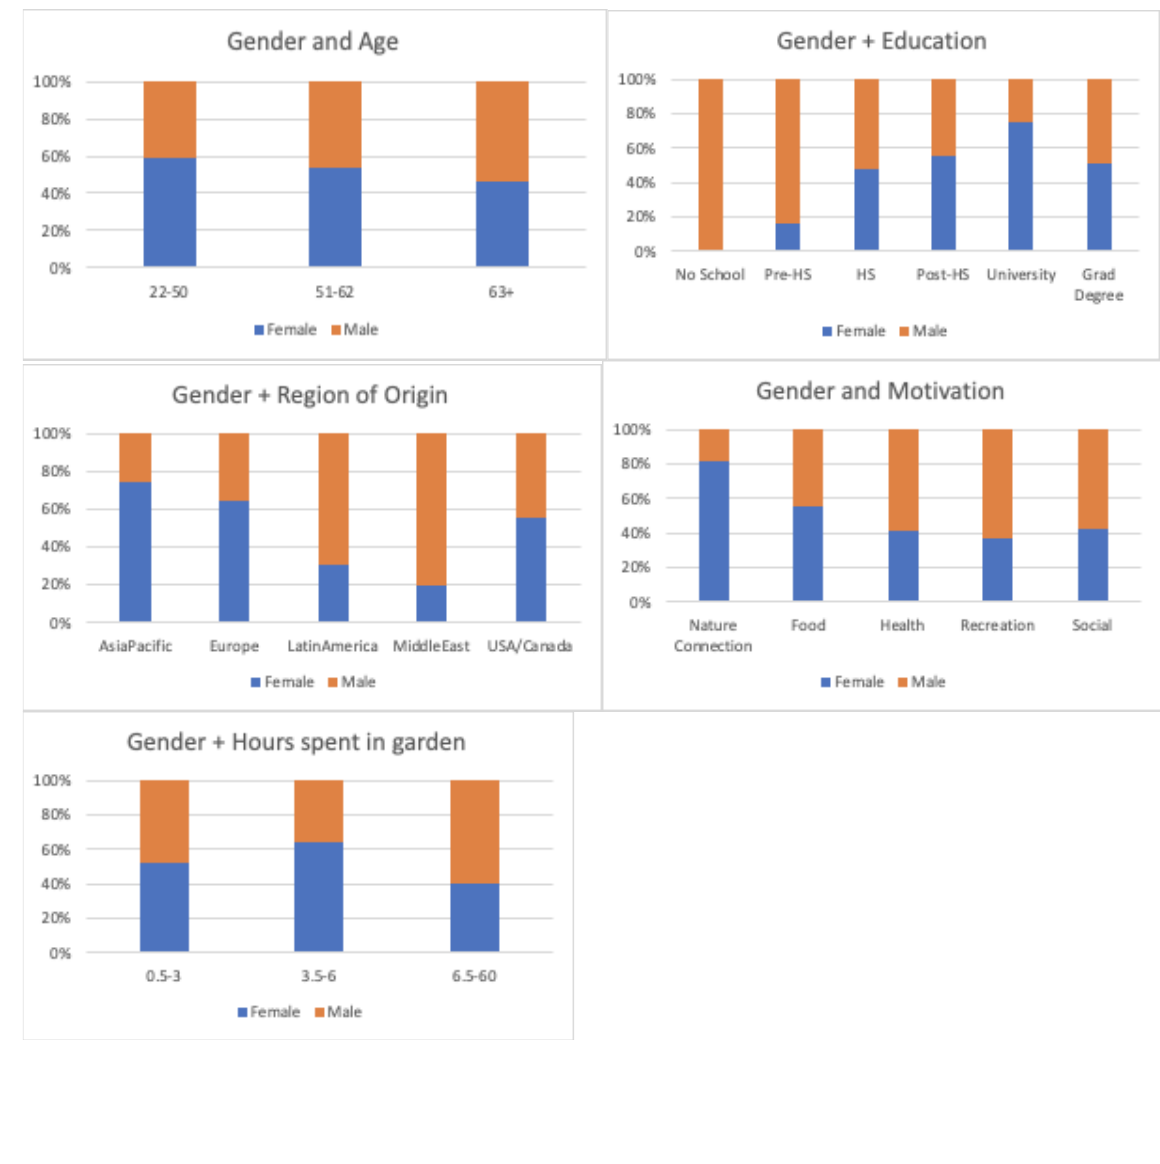
Figure A2.1. Relationships between gender and age, education, region of national origin, motivation for gardening, and hours spent in the